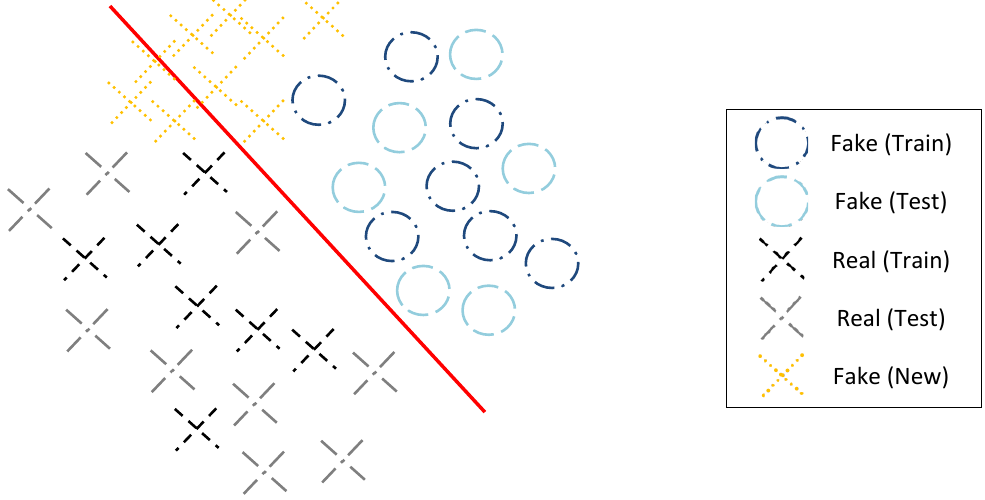
Figure 4. Illustrative Example. Black crosses and dark blue circles are fake and real samples in the training set. Light blue circles are real samples; gray crosses are fake samples from materials present in the training set; orange crosses are fake samples from a new material. The red curve represents the model learnt from the training